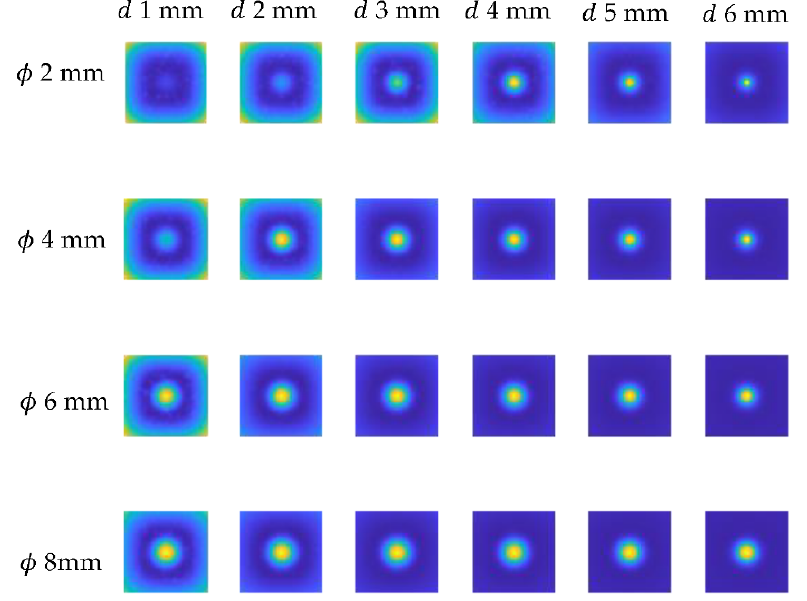
Figure 13. Exemplary results of the trend removal procedure executed on the numerical data shown for chosen defect diameter (  from 2 mm up to 8 mm) and depths (d from 1 mm up to 6